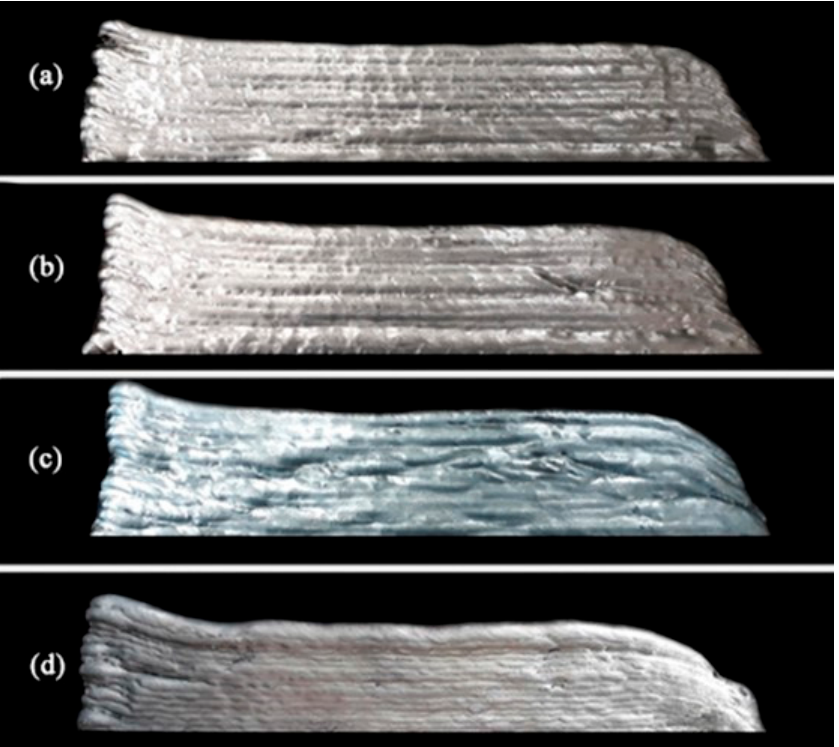
Figure 11. Appearance of the walls: ( a ) WFS = 5 m/min, TS = 41 cm/min; ( b ) WFS = 5.1 m/min, TS = 42 cm/min; ( c ) WFS = 6.1 m/min, TS = 50 cm/min; and ( d ) WFS = 6.5 m/min, TS = 53.5 cm/min (TS stands for travel speed, while WFS represents wire feed speed).